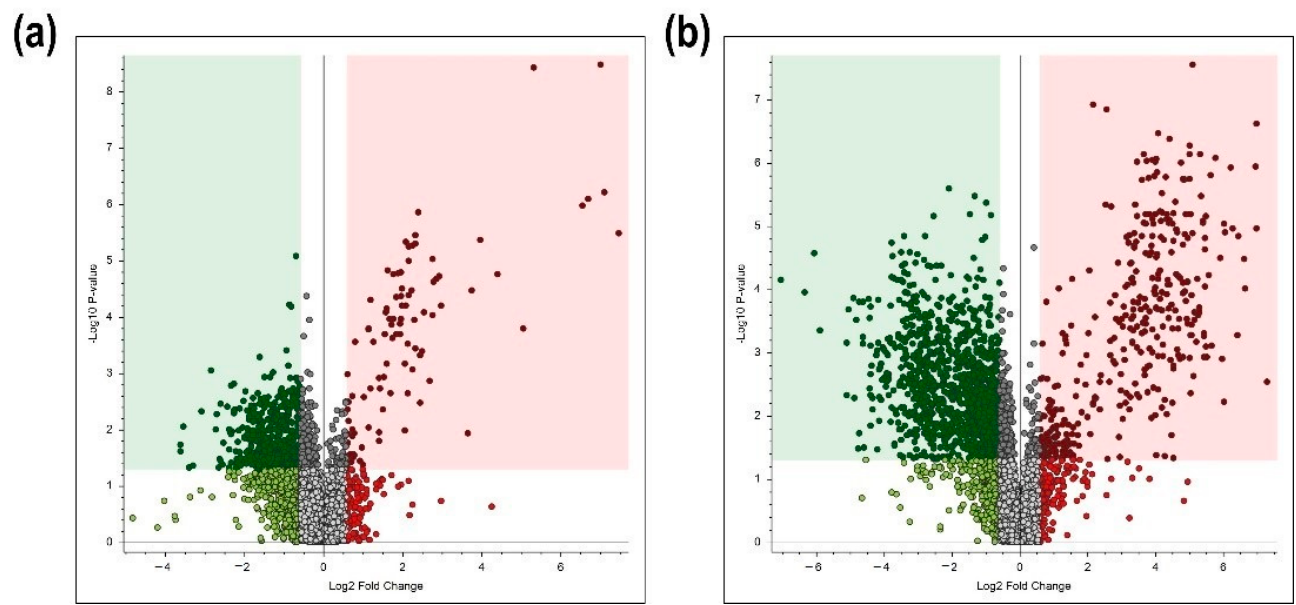
Figure 4 . Volcano plots illustrate the distributions of quantified metabolites in the nicotinamide mononucleotide (NMN)- and nicotinamide (NIM)-pretreated spikes at 7 dpi. The results of ( a ) NMN- and ( b ) NIM-pretreated spikes are shown. The vertical-axis is the − log10 of the p -value and the horizontal-axis is log2 of fold change of NMN- or NIM-pretreated spikes compared to the control ones. Cutoff values of fold change and p -value were 1.5 and 0.05, respectively. The dots indicate detected metabolites containing the unidentified and redundant ones. Red squares indicate significantly accumulated metabolites, while green squares show significantly reduced metabolites.